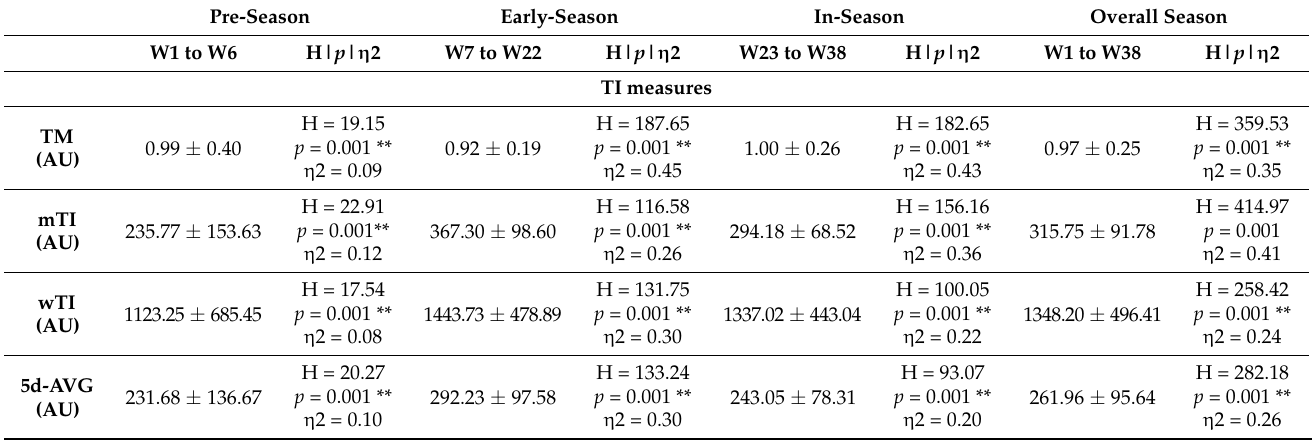
Table 2. Training intensity variations from preseason, early-season, in season and overall.